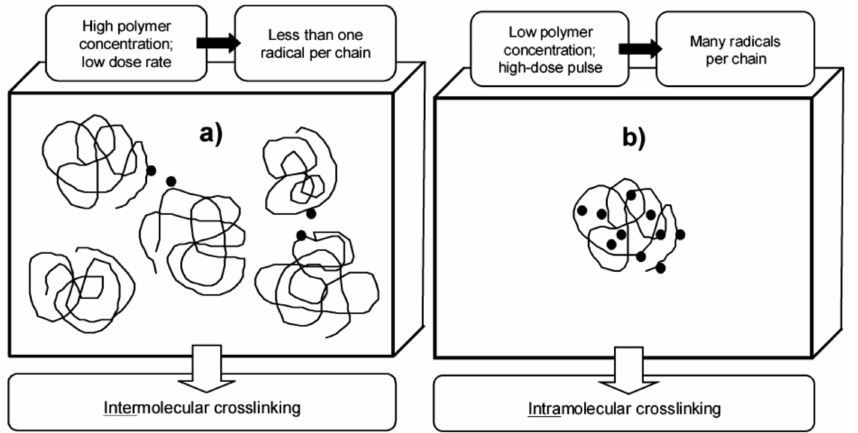
Figure 3. Irradiation conditions promoting ( a ) inter- and ( b ) intramolecular recombination of polymer- derived radicals in solutions. Adapted with permission from [59]; published by American Chemical Society,